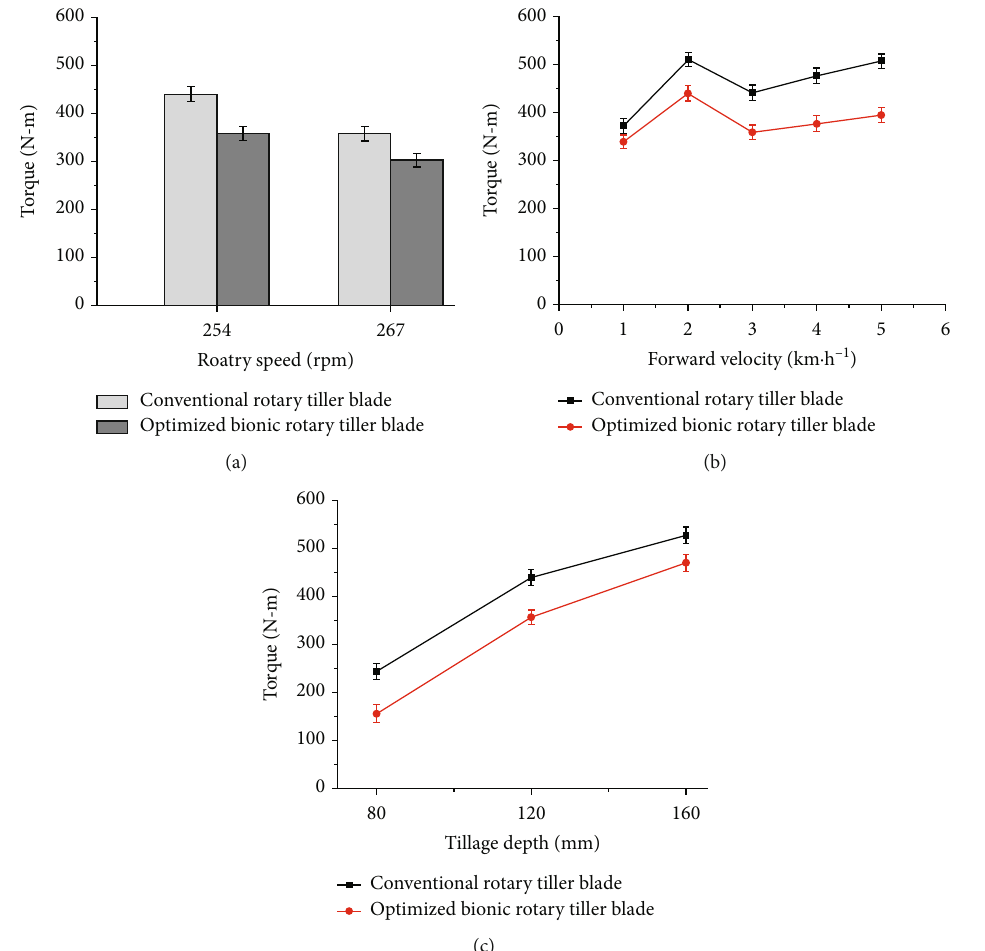
Figure 14: Torques of rotary tiller blades at di ff erent tillage conditions: (a) rotary speed; (b) forward velocity; (c) tillage depth.